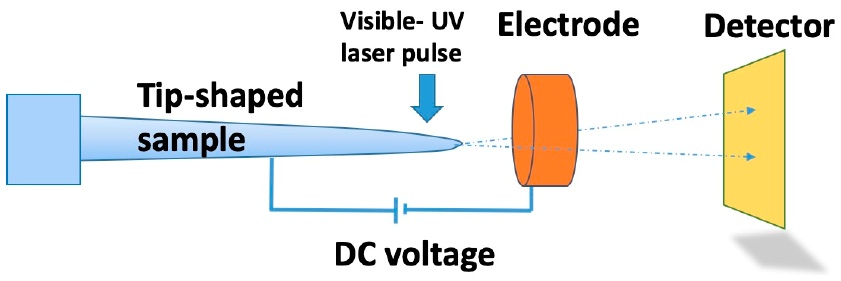
Figure 68. Conventional atom probe tomography.